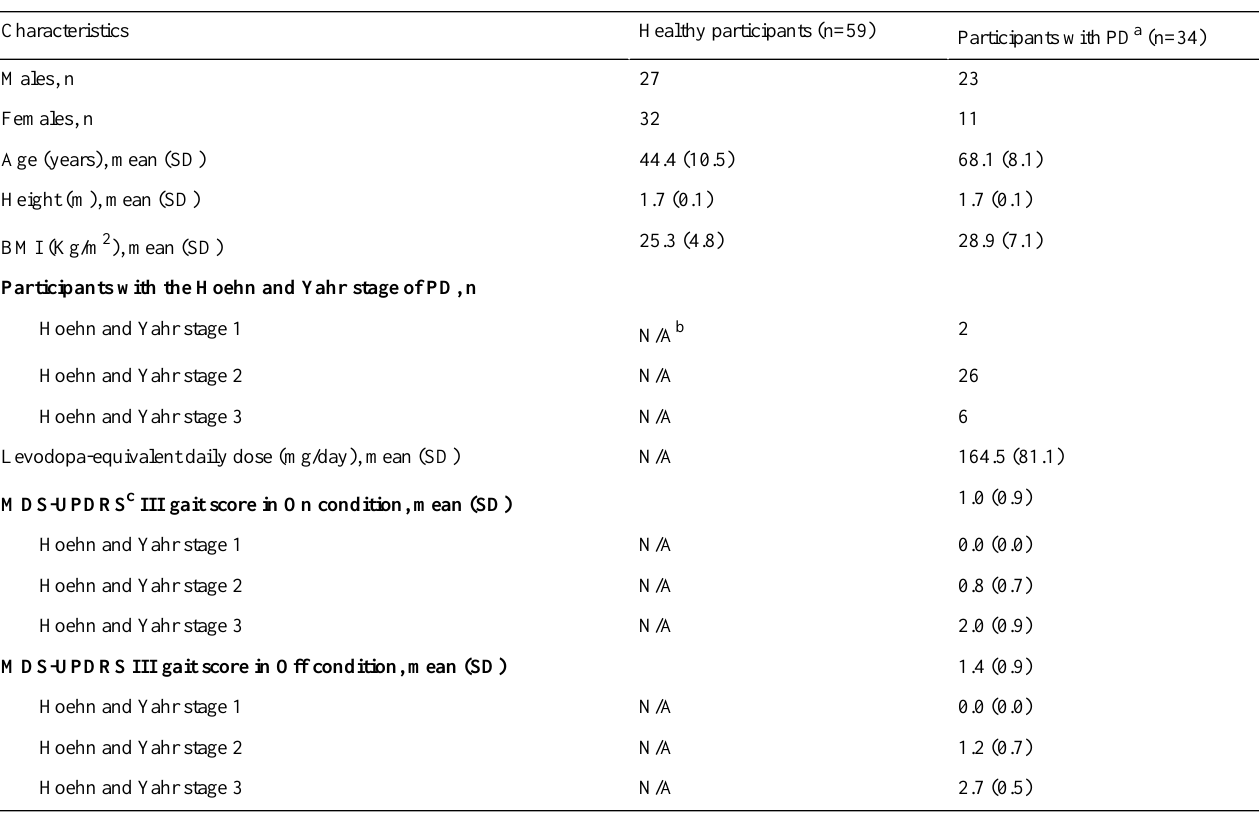
Table 1. Clinical and demographic